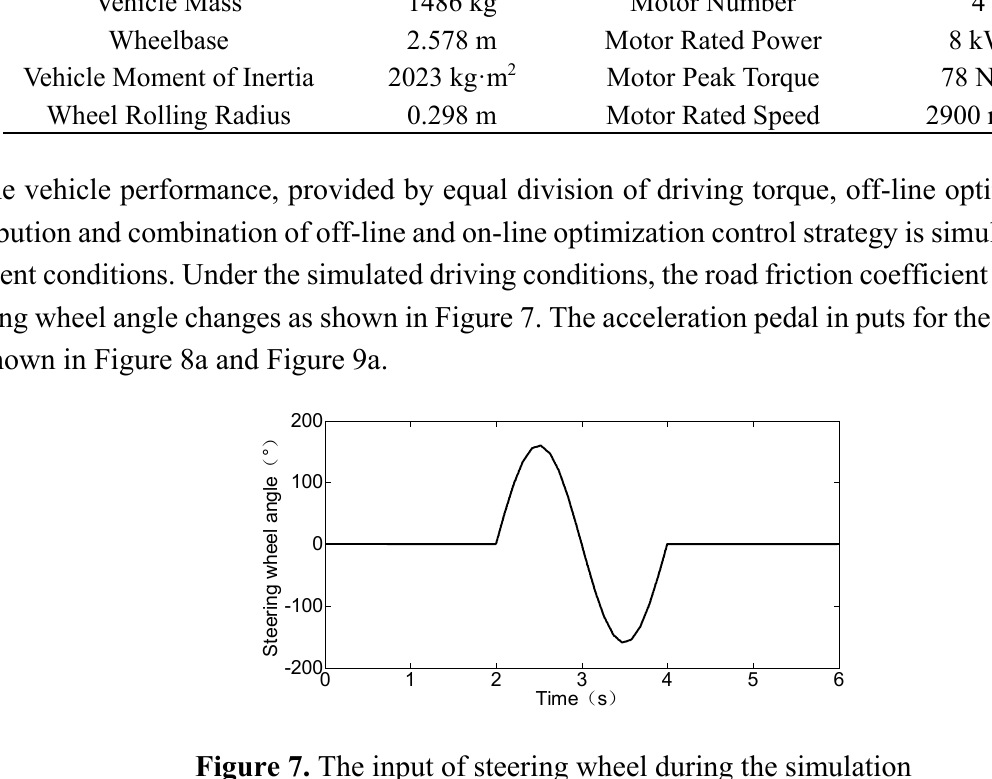
Figure 7. The input of steering wheel during the